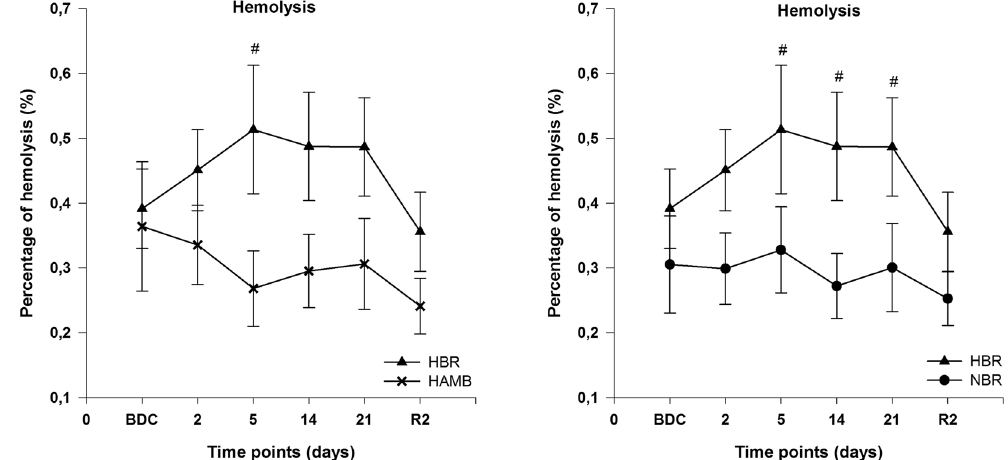
Figure 2. Assessment of hemolysis; data are means ± SEM; units are percent (%); HBR = hypoxic bed rest (n = 12–14); NBR = normoxic bed rest (n = 11–13); HAMB = hypoxic ambulation (n = 12); BDC = Baseline Data Collection; R2 = 2 days after the end of condition; # Significant difference between HBR and HAMB or NBR (p < 0.05).